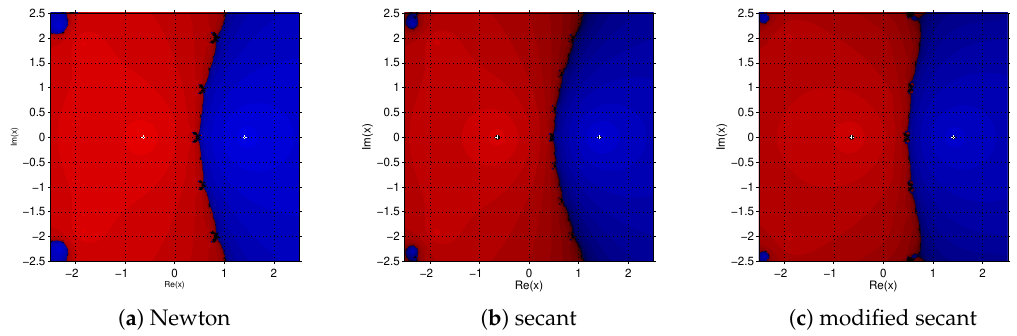
Figure 2. Dynamical planes for f 1 ( z ) = sin ( z ) − z 2 +